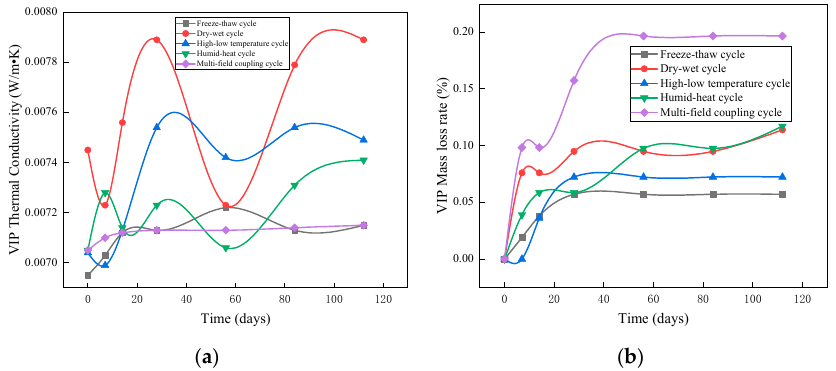
Figure 6. Changes in vacuum insulation panels in weathering resistance tests: ( a ) changes in thermal conductivity of vacuum insulation panels, and ( b ) changes in mass loss of vacuum insulation panels.